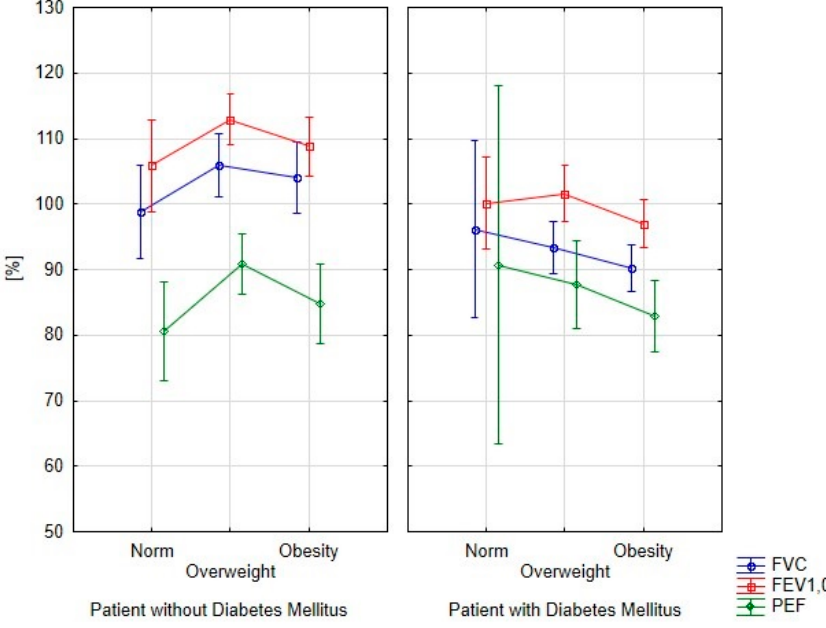
Figure 2. Spirometry parameters depending on BMI in patients with and without diabetes mellitus.